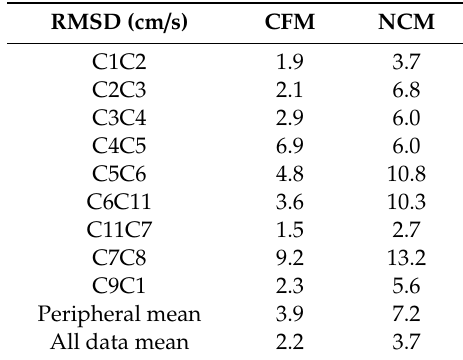
Table 1. Comparison of RMSDs for the RACs between the CAT-observed and CFM-derived currents, and between the CAT-observed and NCM-derived currents.